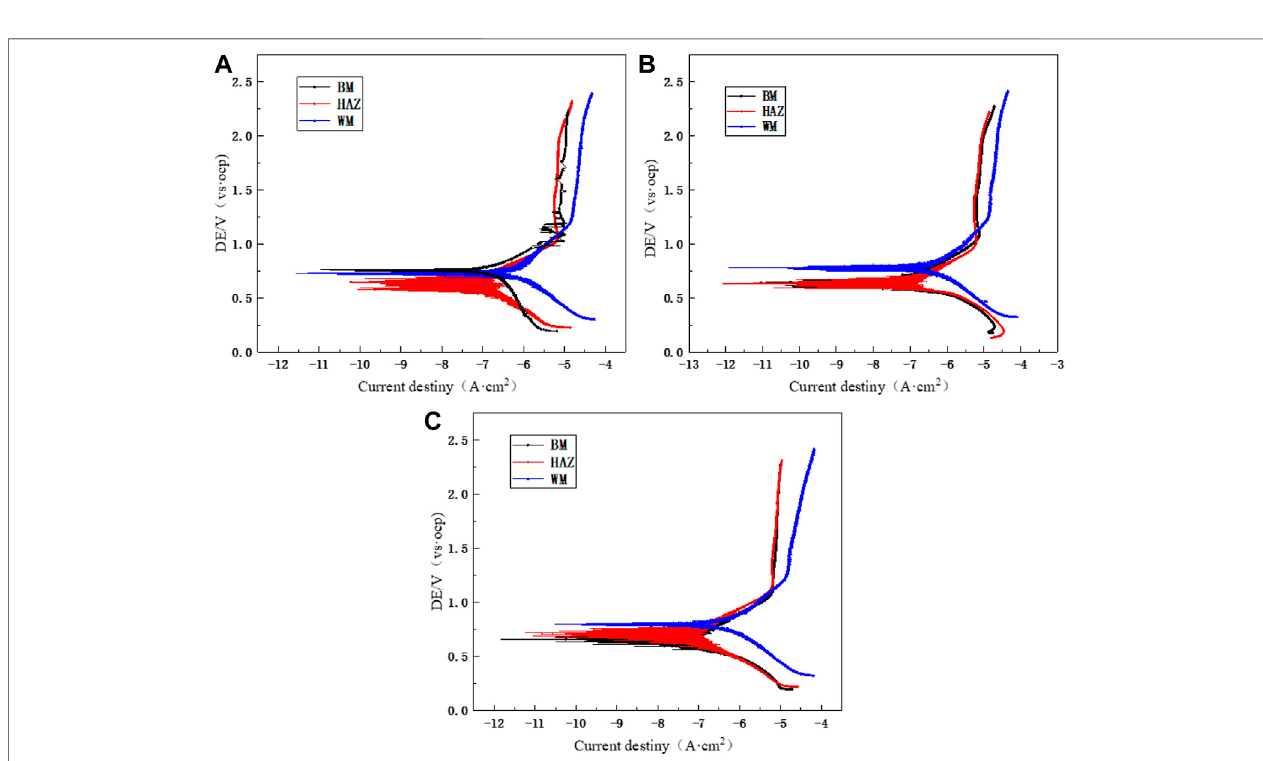
FIGURE 11 | Polarization curves of the TA2 titanium alloy welded joint after 12 h of scouring in arti fi cial seawater: (A) 1.85 m/s, (B) 3 m/s, and (C) 6 m/s.